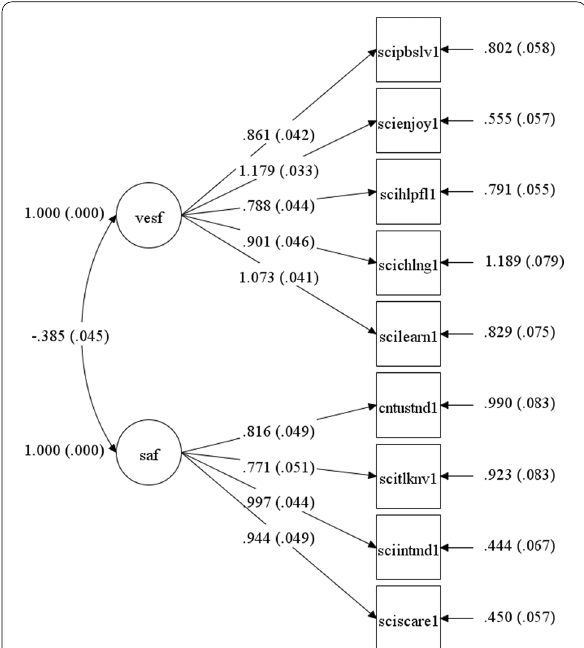
Fig. 1 Two‑factor model with one residual‑correlation at Time 1 from CFA. Note. ‘vesf’ is the value and enjoyment of science factor